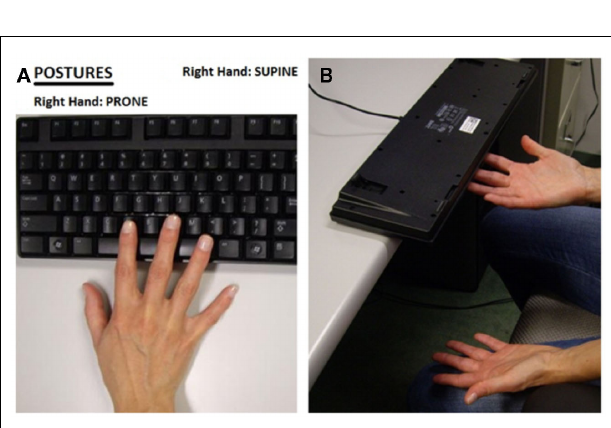
FIGURE 2 | On each trial, participants fixated the centre of a display where a digit (1–9, 5 excluded) appeared for 1,300ms. In half the blocks, digits were classified as smaller/larger than five in the other half as even/odd. Participants responded with either their right index and middle finger or their